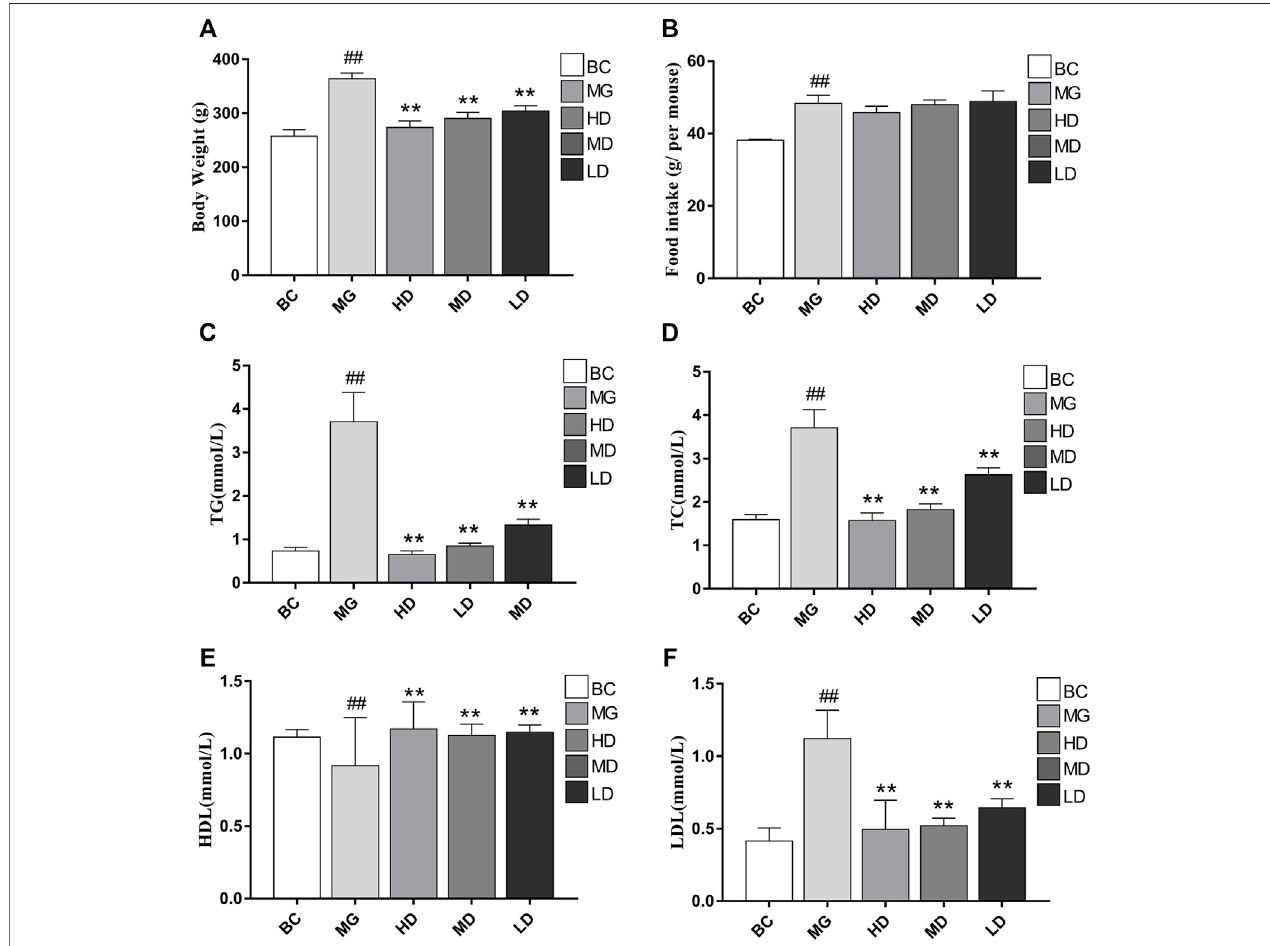
FIGURE 3 | Effects of taking SEJZ for 4 weeks on the physiological and biochemical indices of model group -induced hyperlipidemia. (A) Body weight, (B) food intake, (C) TG, (D) TC, (E) HDL, and (F) LDL ( n = 8, ** p < 0.01 vs. MG; # # p < 0.01 vs. BC).